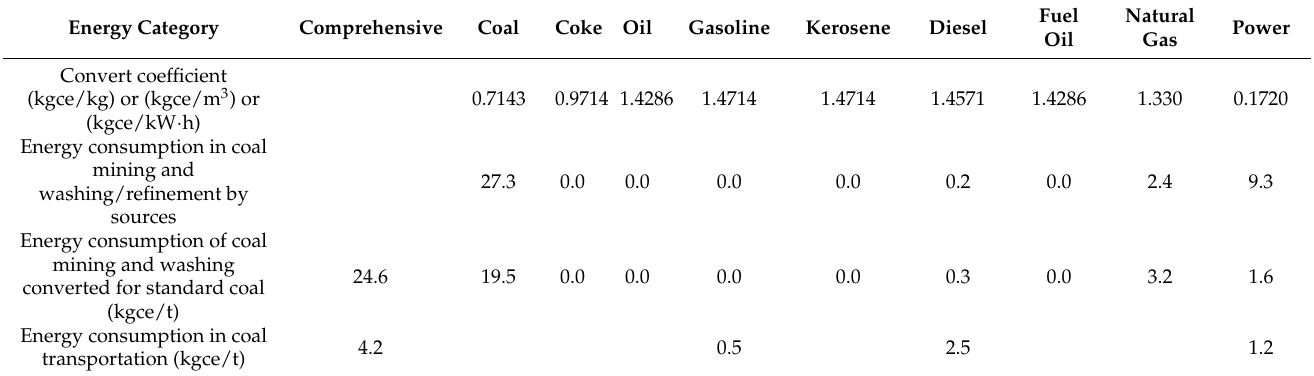
Table 1. The conversion coefficient of standard coal with different energy sources and unit energy consumption in coal mining, washing, and refining process and